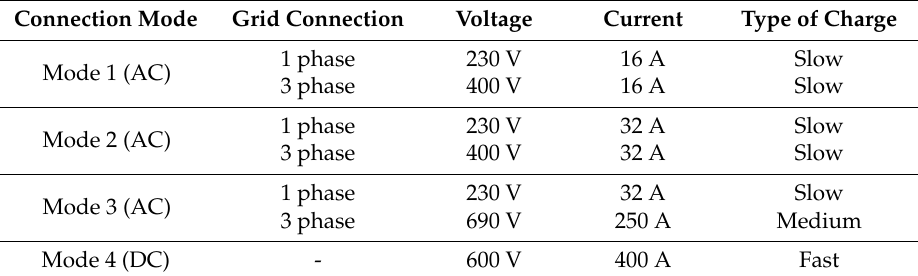
Table 1. Standard charging power levels in the IEC 61851-1 standard